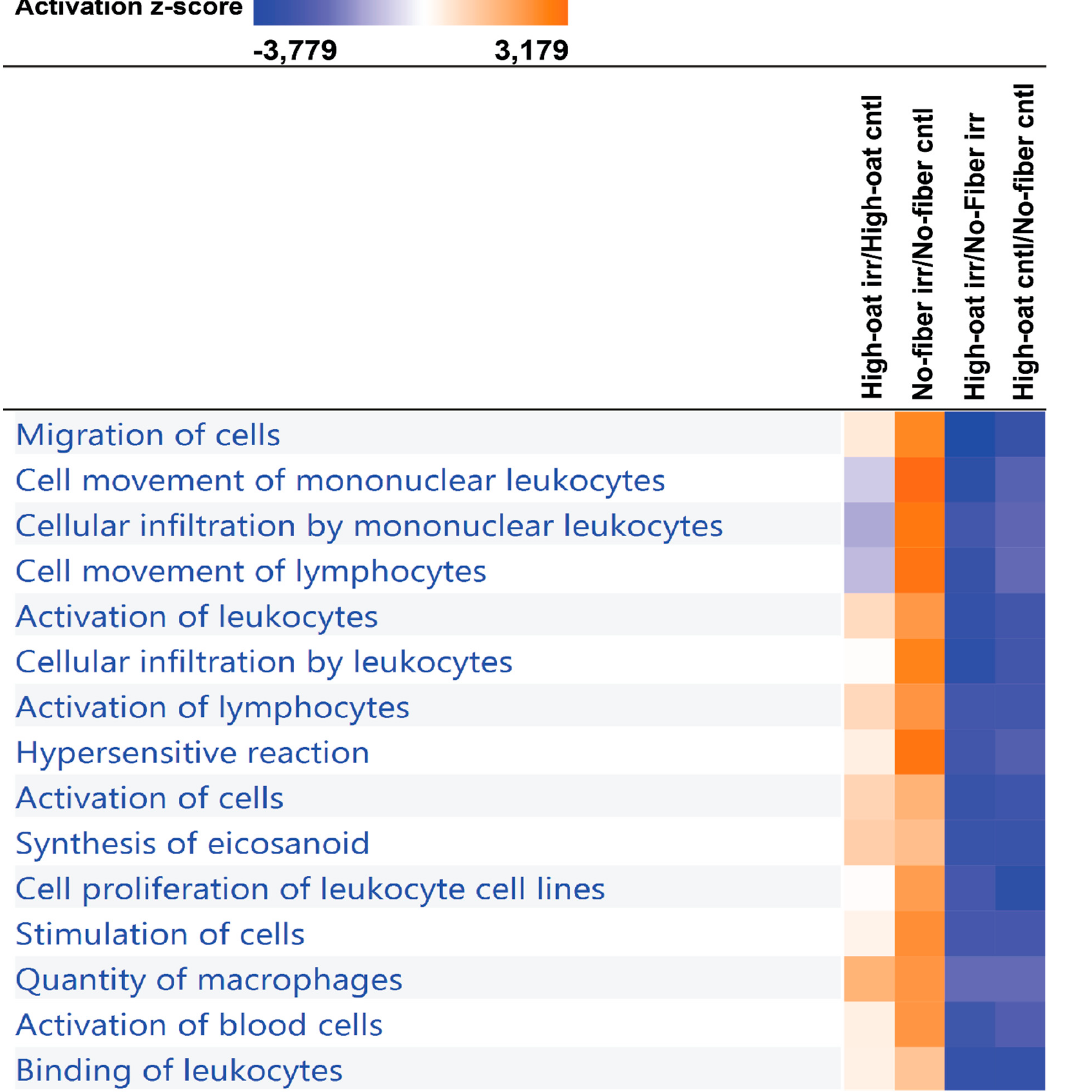
Figure 9. Biological function and disease enrichment analysis. The comparison analysis was used to compare the High-oat irr vs. High-oat cntl, No-fiber irr vs. No-fiber cntl, High-oat irr vs. No-fiber irr, and High-oat cntl vs. No-fiber cntl groups, to observe the top 15 biological functions or diseases associated with the cytokine profiles at ( A ) 1, ( B ) 6, and ( C ) 18 weeks post-irradiation, ordered according to the highest activation z-score. The orange colorations indicate activation of the functions or diseases and the blue colorations indicate inhibition of the functions or diseases.